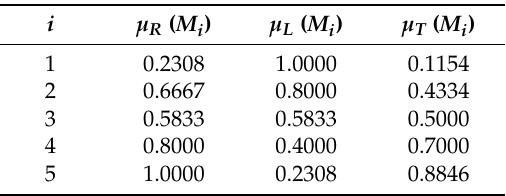
Table 1. Determination of μ total .